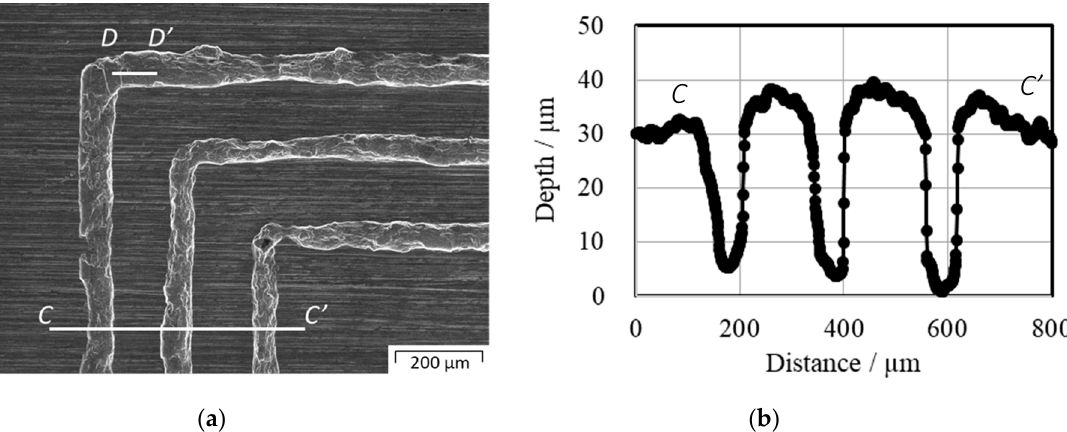
Figure 13. Enlarged SEM image and depth distribution of the micro-embossed oxygen-free copper substrate. ( a ) Enlarged SEM image of micro-embossed oxygen-free copper substrate, ( b ) depth distribution of the micro-embossed oxygen-free copper substrate measured along the line C–C’ . The average micro-emboss width at a depth of 20 µm is 58 µm and the average micro-embossing depth is 35 µm.